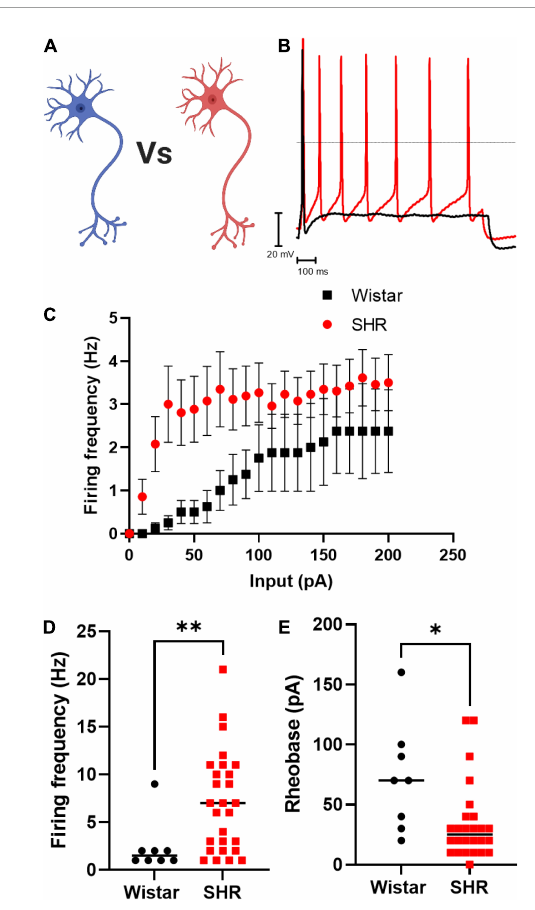
FIGURE1 Primary cultured SHR neurons are more excitable than Wistar neurons Wistar and SHR neurons were cultured alone for a period of 3 days, and their intrinsic electrical excitability measured by whole-cell patch-clamp recordings of neuronal firing rate and rheobase. SHR neurons exhibited a greater firing rate, and a lower rheobase, both indicators of neuronal excitability. (A) Diagram of the experimental design in figure, where Wistar and SHR neurons cultured alone are compored by electrophysiological recordings. (B) Example traces of Wistar and SHR neuron firing induced by current injection are shown demonstrating the higher firing rate in SHR neurons. (C) The average (Mean) firing rate of Wistar and SHR neurons is shown for Wistar and SHR neurons. (D) The maximum firing frequency of SHR neurons when stimulated with 0–200 pA of current was shown to be greater than in Wistar neurons (Medians) (Mann–Whitney test; n = 8, n = 27; p = 0.0068). (E) The rheobase of SHR neurons is reduced relative to Wistar neurons, indicating a smaller current was required to induce neuronal firing (Medians) (Mann–Whitney test; n = 8, n = 26; p = 0.0113).